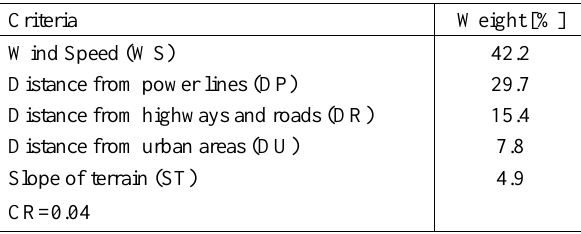
Table 7 . The relative importance of criteria.